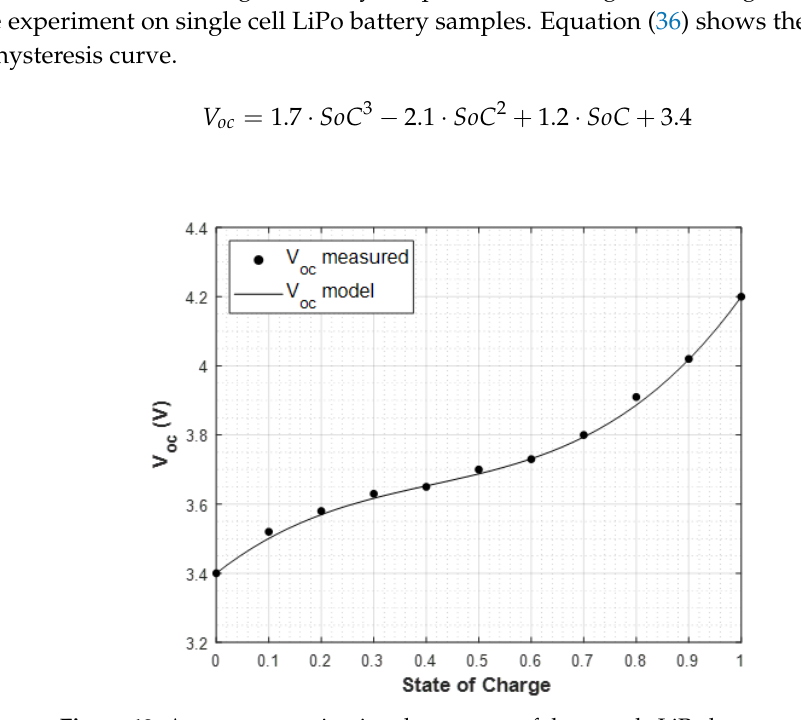
Figure 12. Average open-circuit voltage curve of the sample LiPo battery cells.